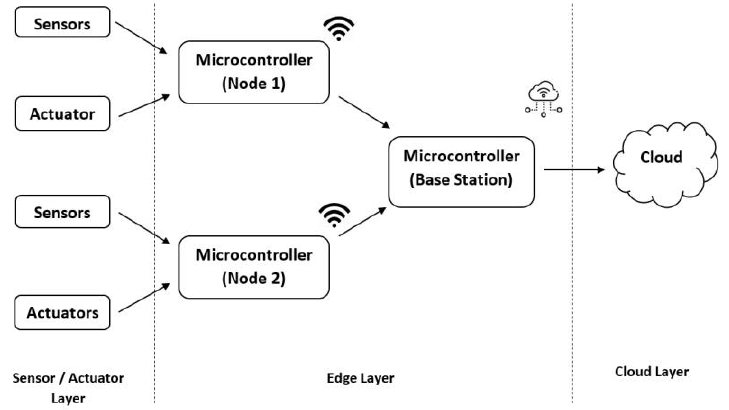
Figure 2. Proposed framework for acquisition of data in greenhouse environment. The proposed model tracked greenhouse characteristics for two crops, Gerbera and Broccoli, in different climates. A microcontroller, Node MCU ESP 32, was connected to all the needed sensors for obtaining the greenhouse parameters, as depicted in Figure 3. A personal computer was used to collect data serially with timestamp values of 1 h for the data logging of various parameters. Temperature and humidity, which were taken using the dht11 sensor, light intensity, which was taken using the LDR Sensor, CO 2, which was taken using the MQ2 sensor, and soil moisture, which was taken using Cu leads, were